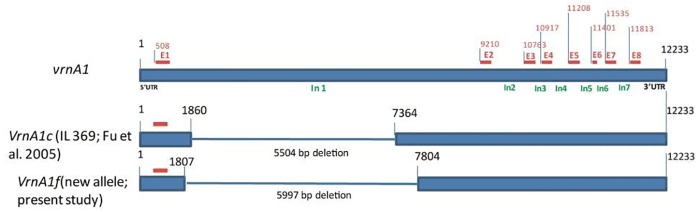
Schematic diagram of vrn-A1 gene, Vrn-A1c and new allelic variant Vrn-A1f.The eight exons are show as red boxes with numbers E1 to E8 and introns are shown as In1 to In 7. The novel deletion is shown in intron 1 between 1807 and 7804 bp relative to recessive allele vrn-A1 (AY747600) and dominant allele Vrn-A1c (AY747599). Nucleotide numbers are based on the sequence of vrn-A1 (AY747600).